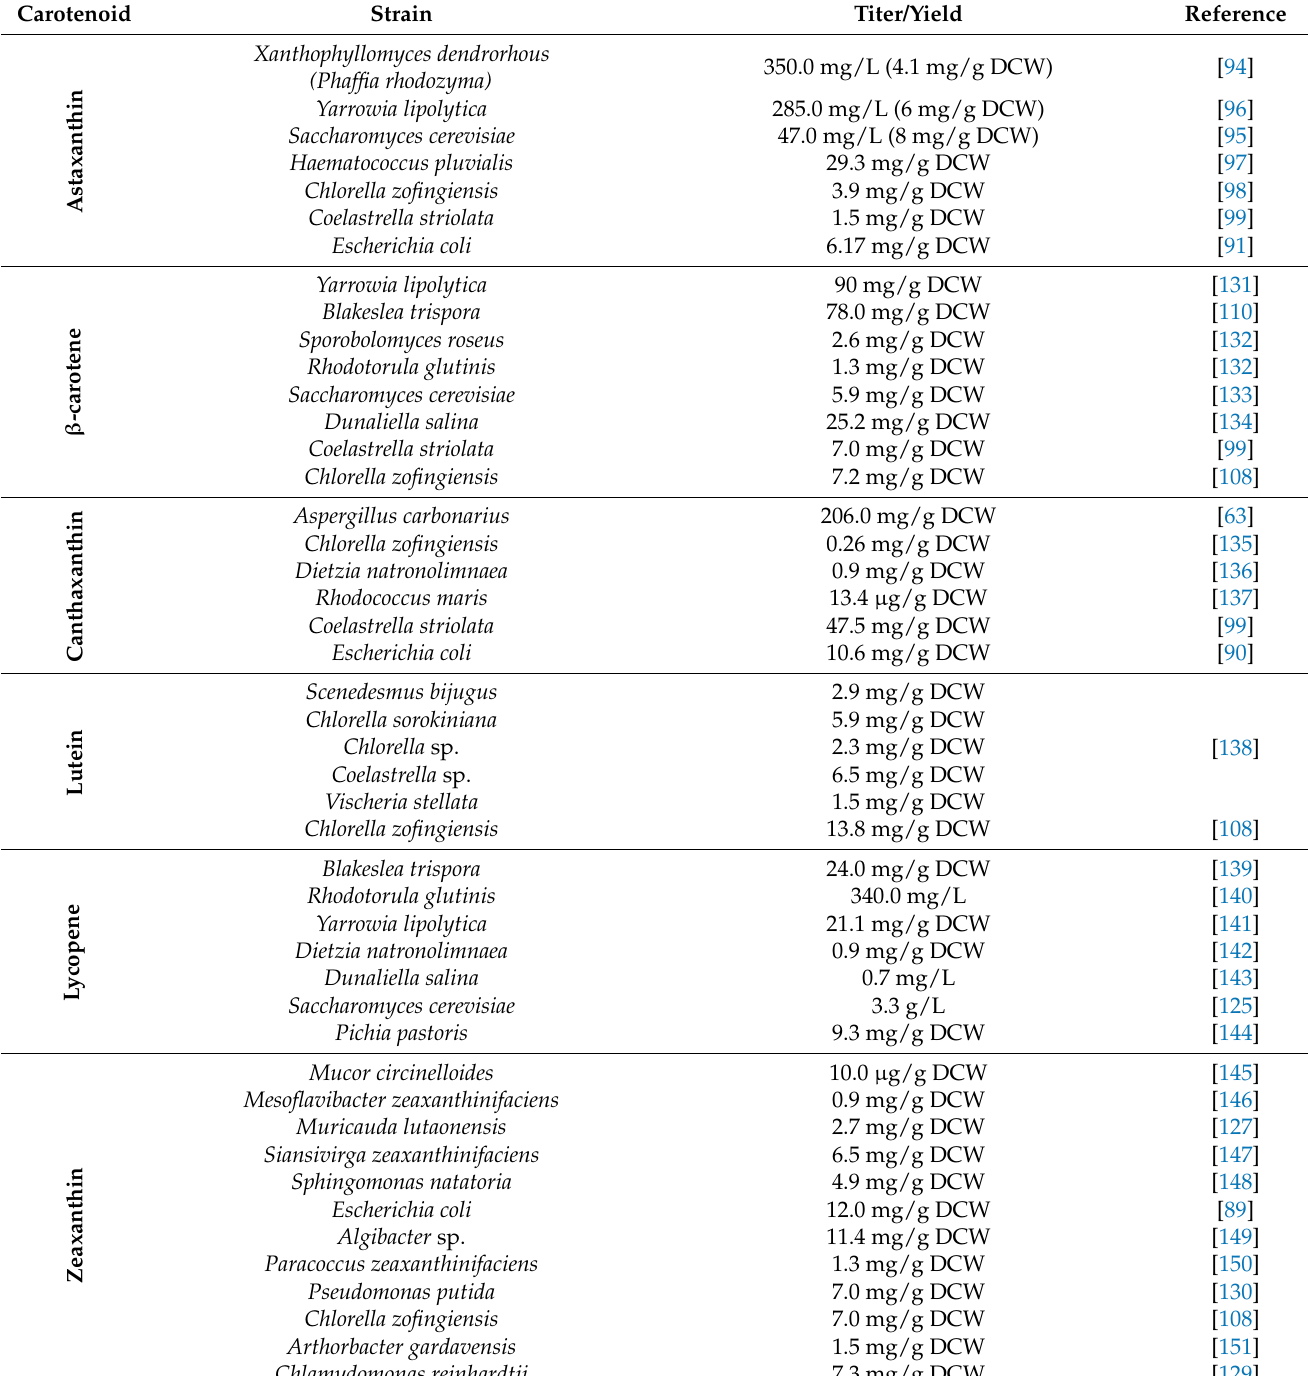
Table 1. Summary of carotenoids production from different microbial sources based on data provided by authors.